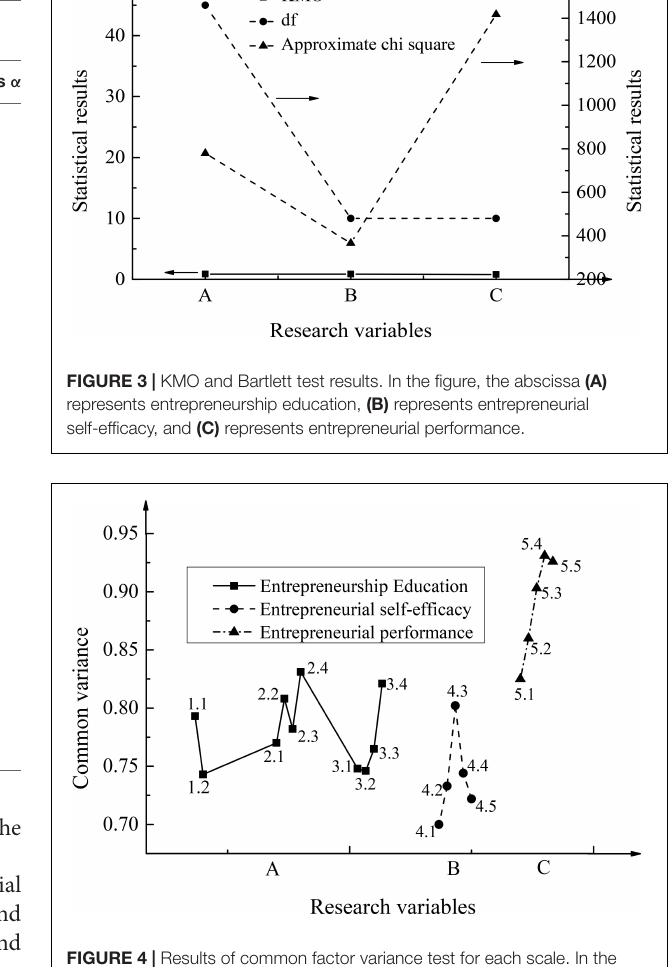
FIGURE 4 | Results of common factor variance test for each scale. In the figure, 1.1–5.5 correspond to the questions in the